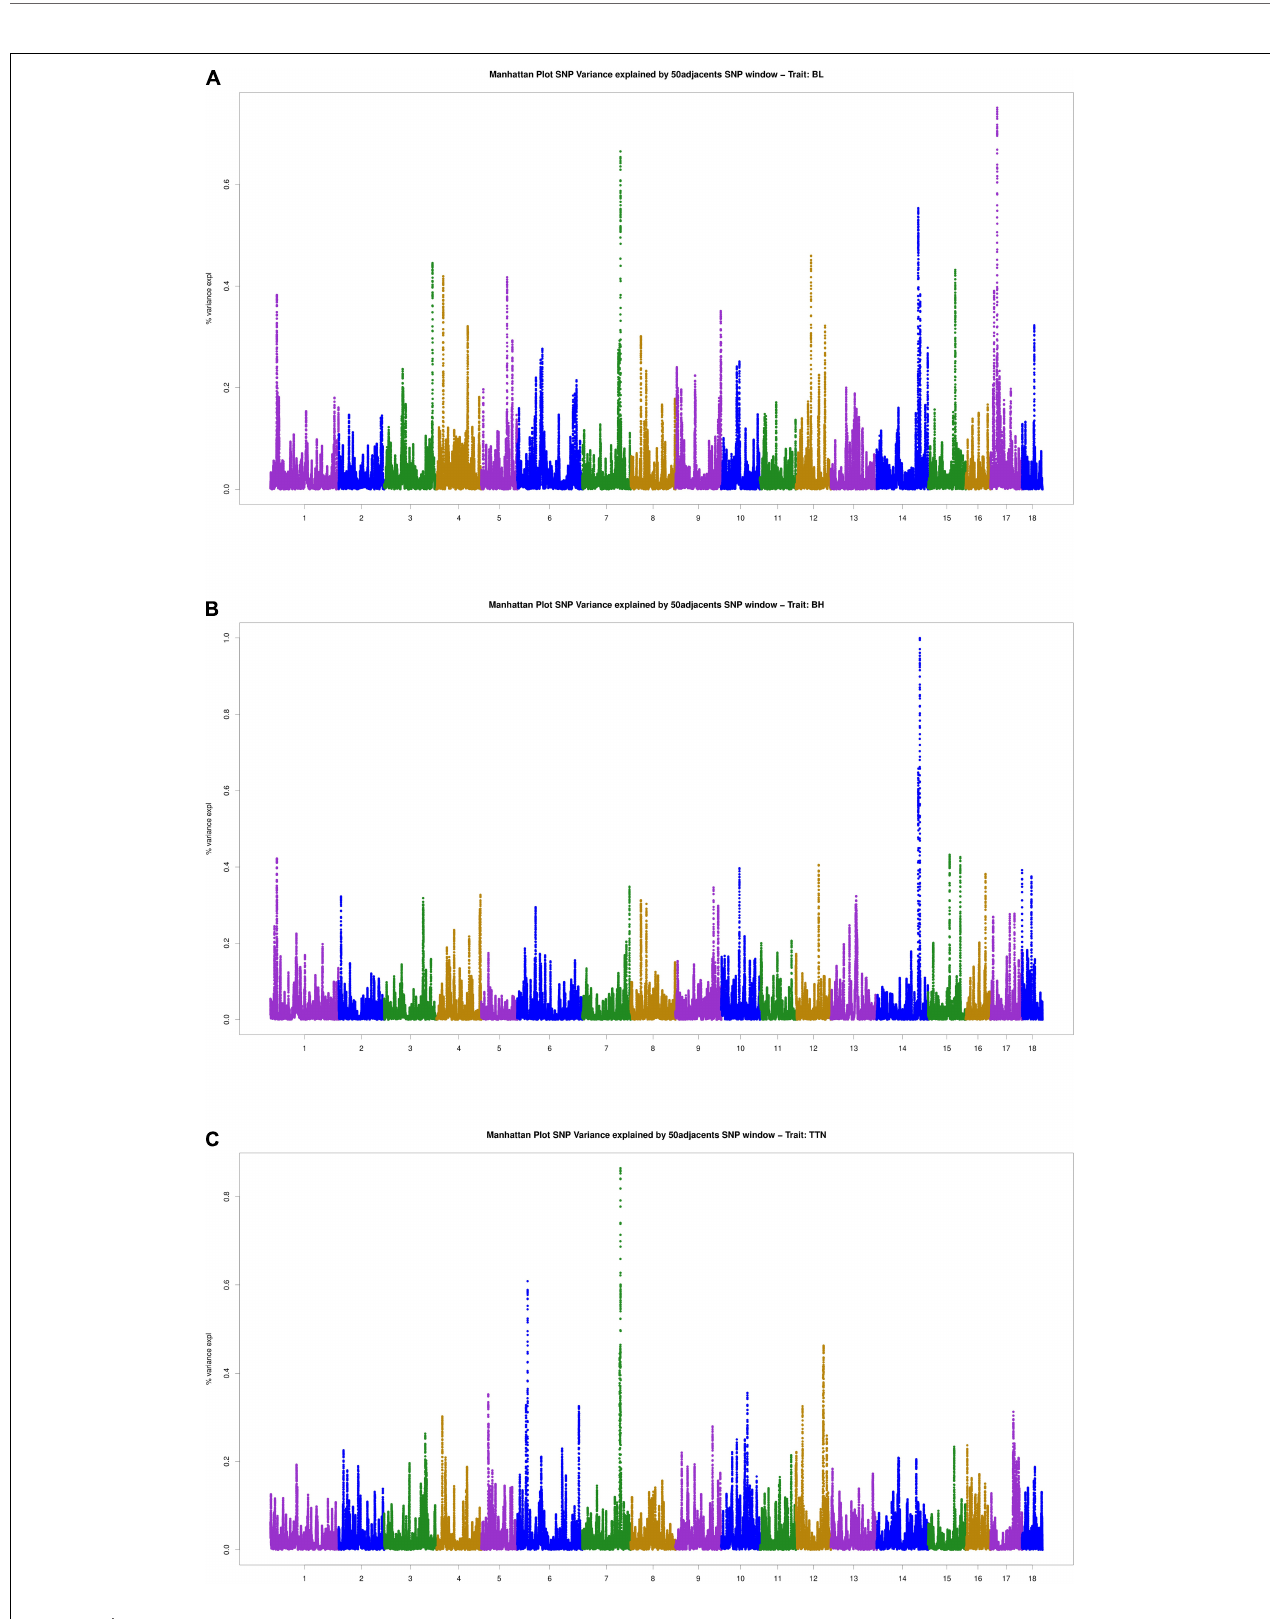
FIGURE 2 | Manhattan plots for the percentage of genetic variance by 50 adjacent SNP windows for (A) body length, (B) body height, and (C) total teat number. Variance expl (%) represents the proportion of genetic variance explained by 50 adjacent SNPs.